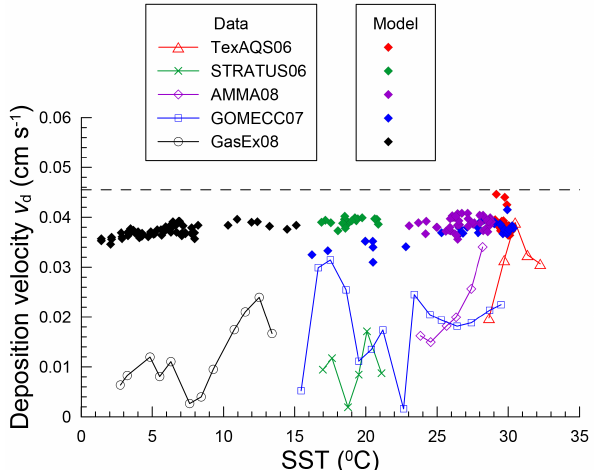
Figure 1. Ozone dry deposition velocity ( v d ) as a function of sea surface temperature (SST) from five field experiments (Helmig et al., 2012; L. Bariteau, personal communication, 2016) and the corresponding values obtained from the ACCESS-UKCA model using the default parameterisation for ozone deposition to the ocean involving a constant surface resistance of r c = 2200sm − 1 . The dashed line is the ceiling value corresponding to 1 /r c = 100 / 2200 = 0 . 0455cms − 1 .